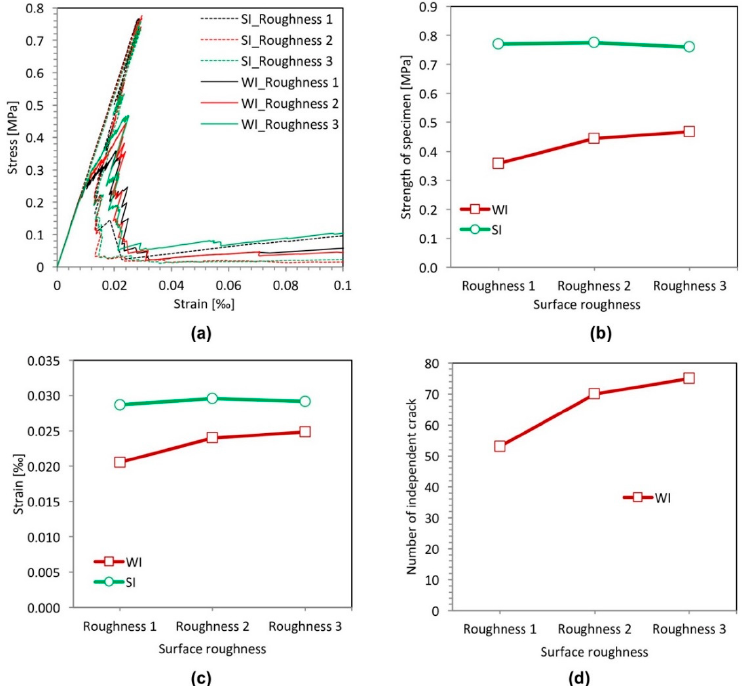
Figure 12. Simulated results of the filler surface roughness effect analyses for specimens with a strong interface (SI) and a weak interface (WI). ( a ) Stress-strain relation; ( b ) strength; ( c ) strain at peak stress; ( d ) number of independent cracks.